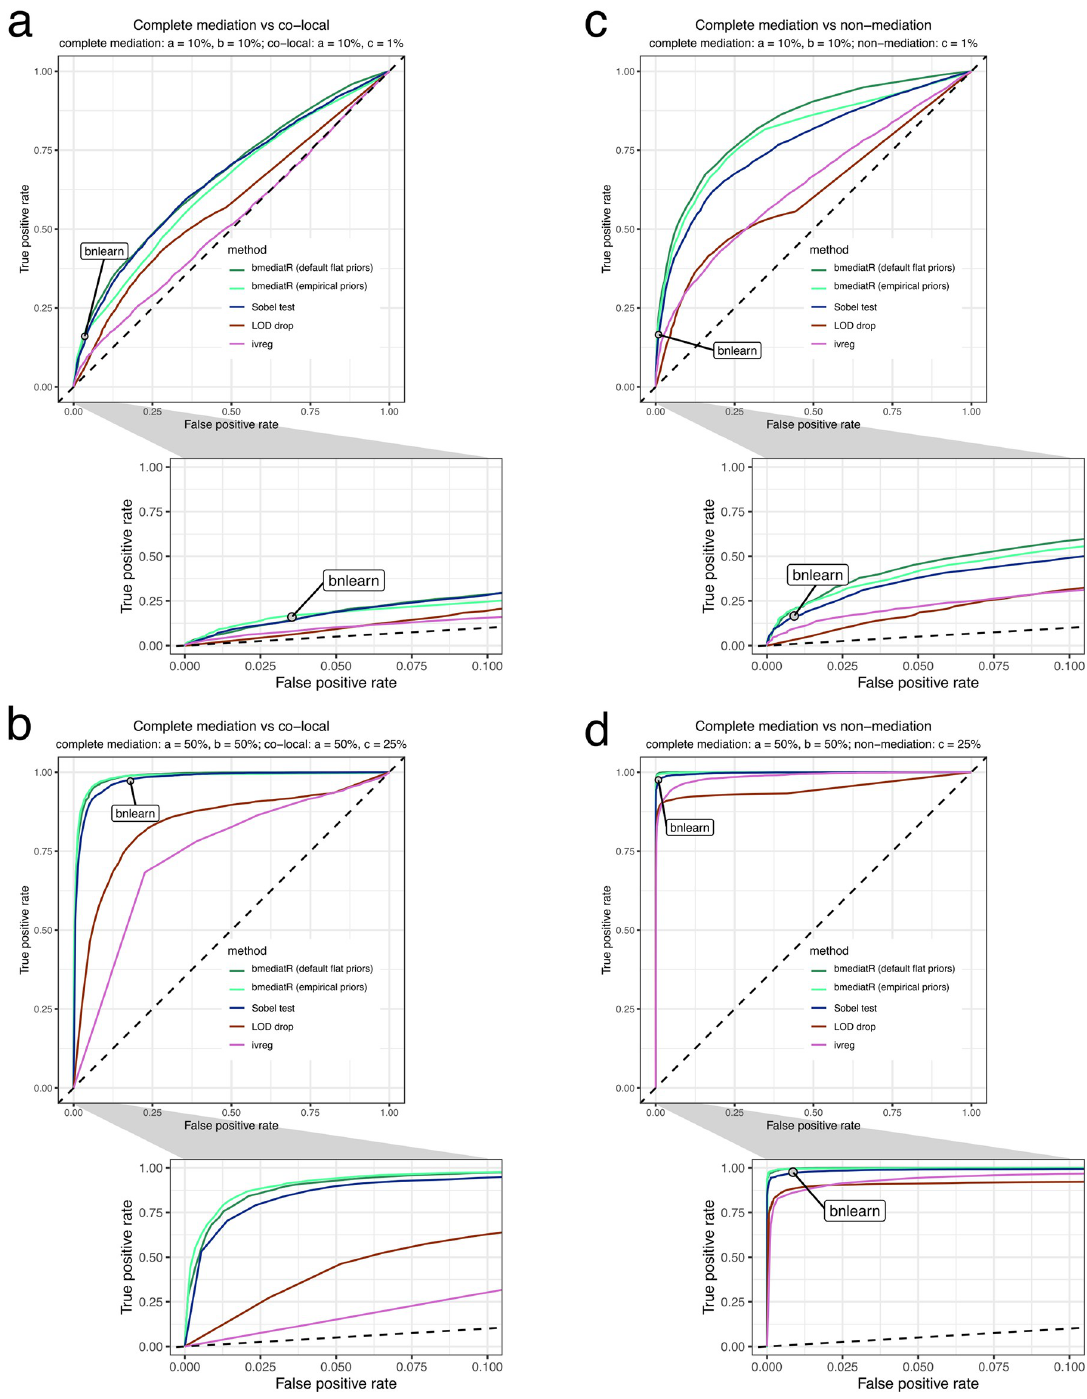
Fig 3. Performance of Bayesian model selection compared with other methods in distinguishing complete mediation from (a-b) co-local and (c-d) non-mediation. True positive rates (power) and false positive rates over a range of ( p -value or posterior probability) thresholds were estimated from 5,000 simulations of 24 individuals according to a balanced bi-allelic variant X. Results are shown for data simulated with both (a-c) small genetic effects (X ! M: 10%, M ! Y: 10%) and (b-d) large genetic effects (X ! M: 50%, M ! Y: 50%). Diagonal dashed line is included for reference, representing a classifier with no ability to distinguish complete mediation from co- local or non-mediation. Note that bnlearn is represented by a point rather than a curve because (in our use of that method) it returns only a single, optimum model and so is not amenable to thresholding. See S7 Fig for methods’ performance in distinguishing partial mediation from co-local and non-mediation.